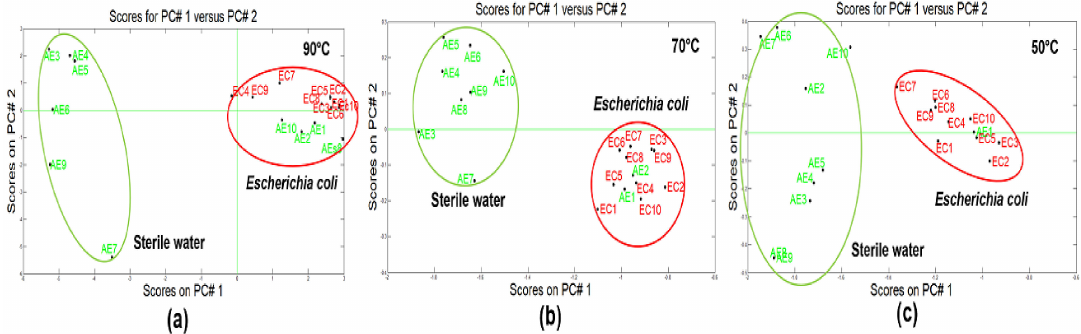
Figure 3. Plotted PCA of sterile water and Escherichia coli a: ( a ) 90 ◦ C, ( b ) 70 ◦ C and ( c ) 50 ◦